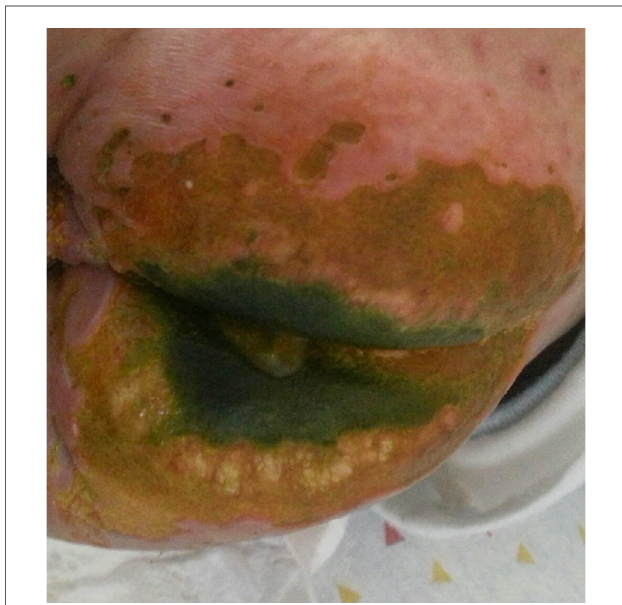
FIGURE 5 Widespread ulceration on the buttocks and scrotum with a central black eschar in their center and yellow-green exudate in a 5-month-old girl with DOCK8 de fi ciency, consistent with Candida and Pseudomonas